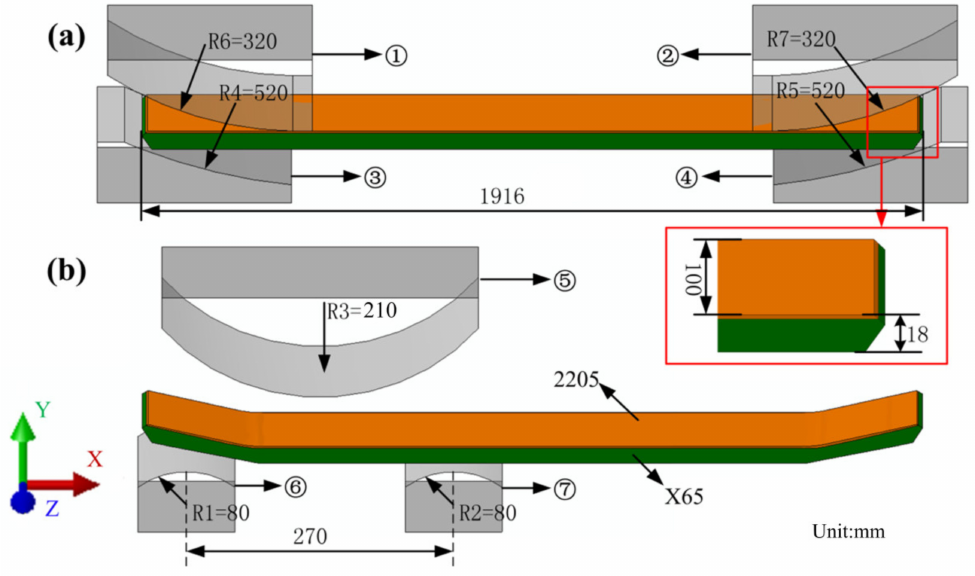
Figure 1. Three-dimensional finite element (FE) model for: ( a ) pre-bending and ( b ) the JCO forming process.( 1 (cid:79) and 2 (cid:79) are the upper pre-bending dies, 3 (cid:79) and 4 (cid:79) are the lower pre-bending dies, 5 (cid:79) is the upper JCO forming die, and 6 (cid:79) and 7 (cid:79) are the lower JCO forming dies).